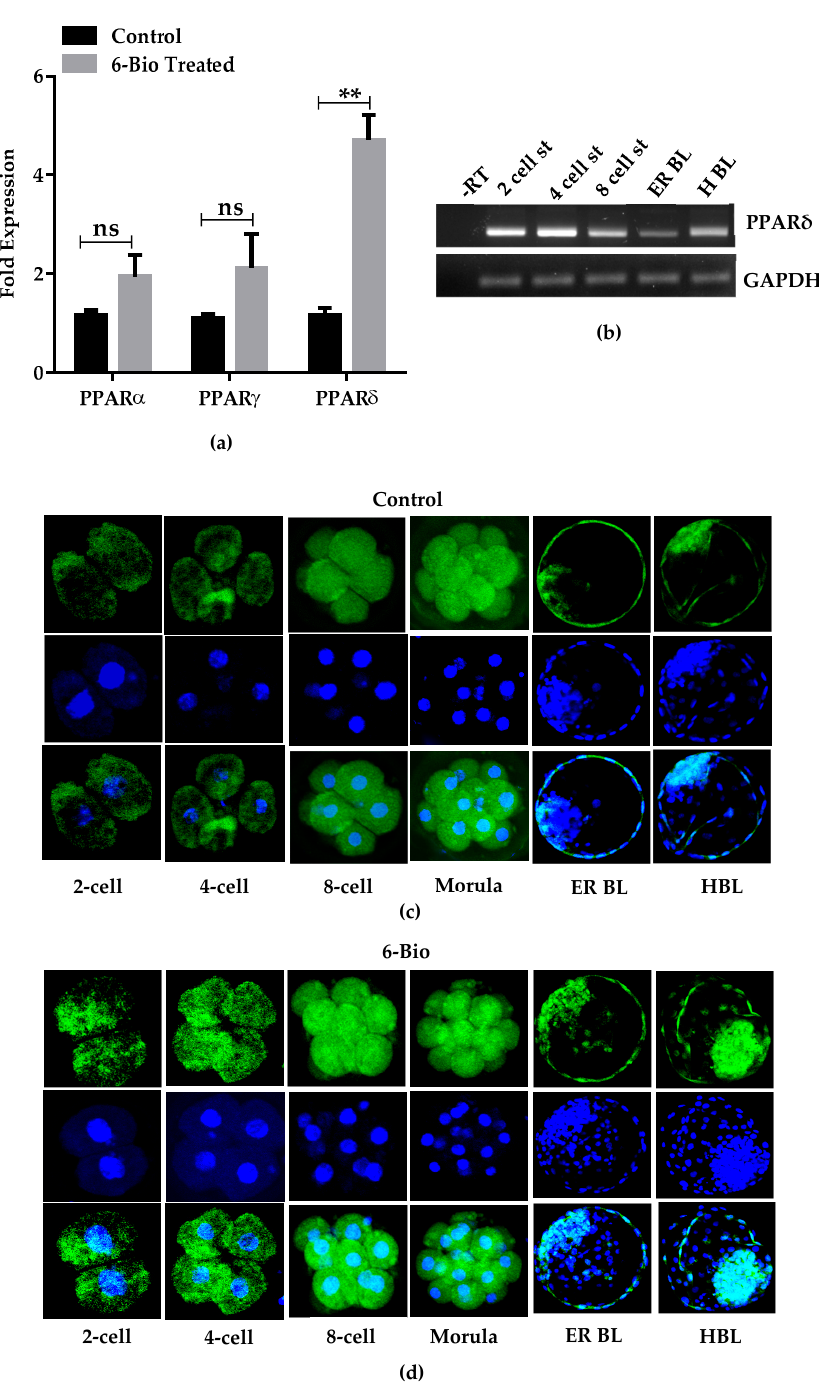
Figure 3. PPAR δ expression in response to Wnt activation during bovine embryonic development. ( a ) Relative mRNA expression analysis of PPAR family in response to Wnt stimulation with its agonist 6-Bio (400 nM). n = 5 BLs, experiment performed in triplicate sets. ns; non-significant, ** p < 0.01; indicates significant di ff erence. ( b ) RT-PCR displaying the PPAR δ expression during the time course of bovine embryonic development. ( c , d ) Immunofluorescence analysis showing the concomitant increase in the PPAR δ expression during di ff erent stages of bovine pre-implantation development in 6-Bio (400 nM) treated group and control group. Original magnification 100 ×